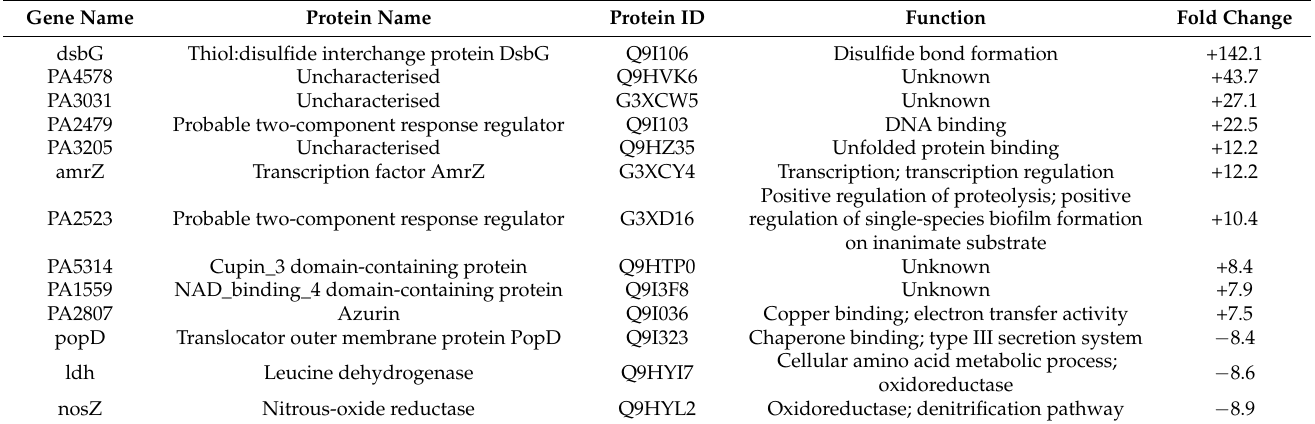
Figure 3. Volcano plot generated from two-sample t -tests showing the distribution of all identified proteins (post-filtration of contaminants). The x -axis denotes fold change (log2 LFQ intensity differ- ence), and the y -axis denotes the p value ( − log10 p value). Statistically significant proteins ( p < 0.05) lie above the horizontal, dashed line, and proteins with a fold change of ≥ 1.5 are to the right and left of the vertical lines. The top ten most increased and decreased proteins in abundance are coloured red and blue, respectively. The corresponding gene names are annotated, and the protein products and corresponding functions are listed in Table 1. Table 1. The top 20 differentially abundant proteins identified in SBC3-treated P. aeruginosa